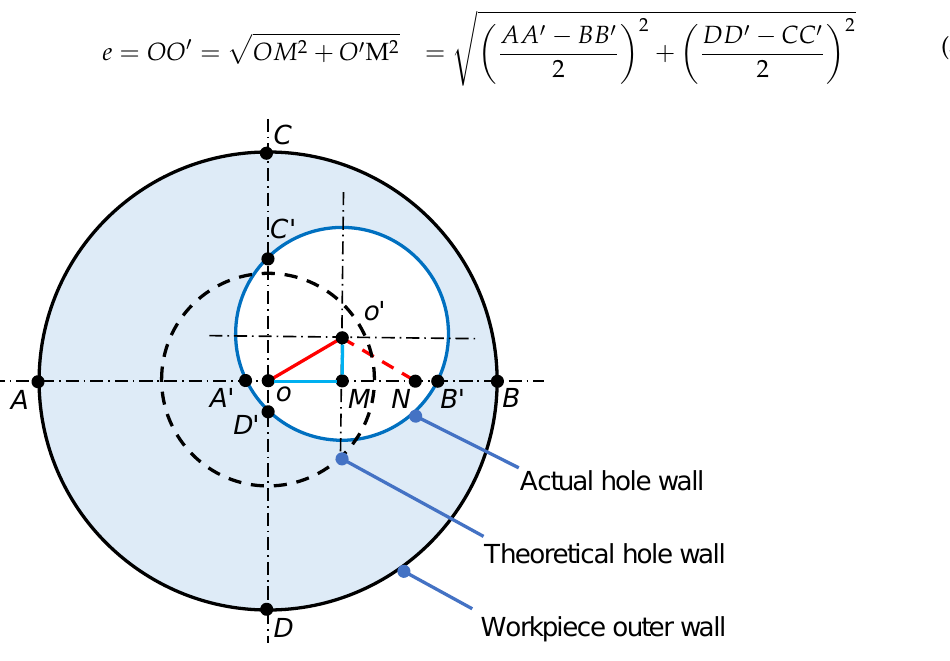
Figure 8. Axial eccentric hole